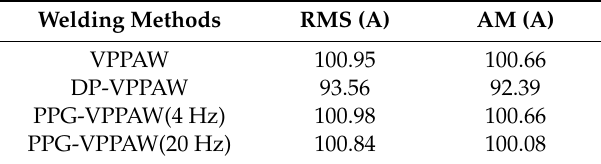
Table 3. The root mean square (RMS) and absolute mean (AM) values of current.